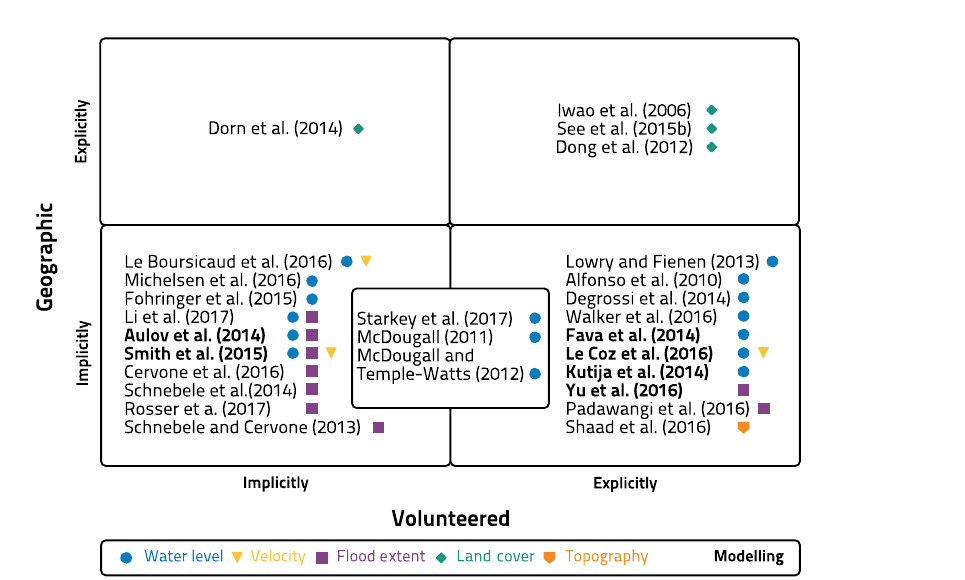
Figure 3. Selected studies represented in the typology of VGI (volunteered geographic information).